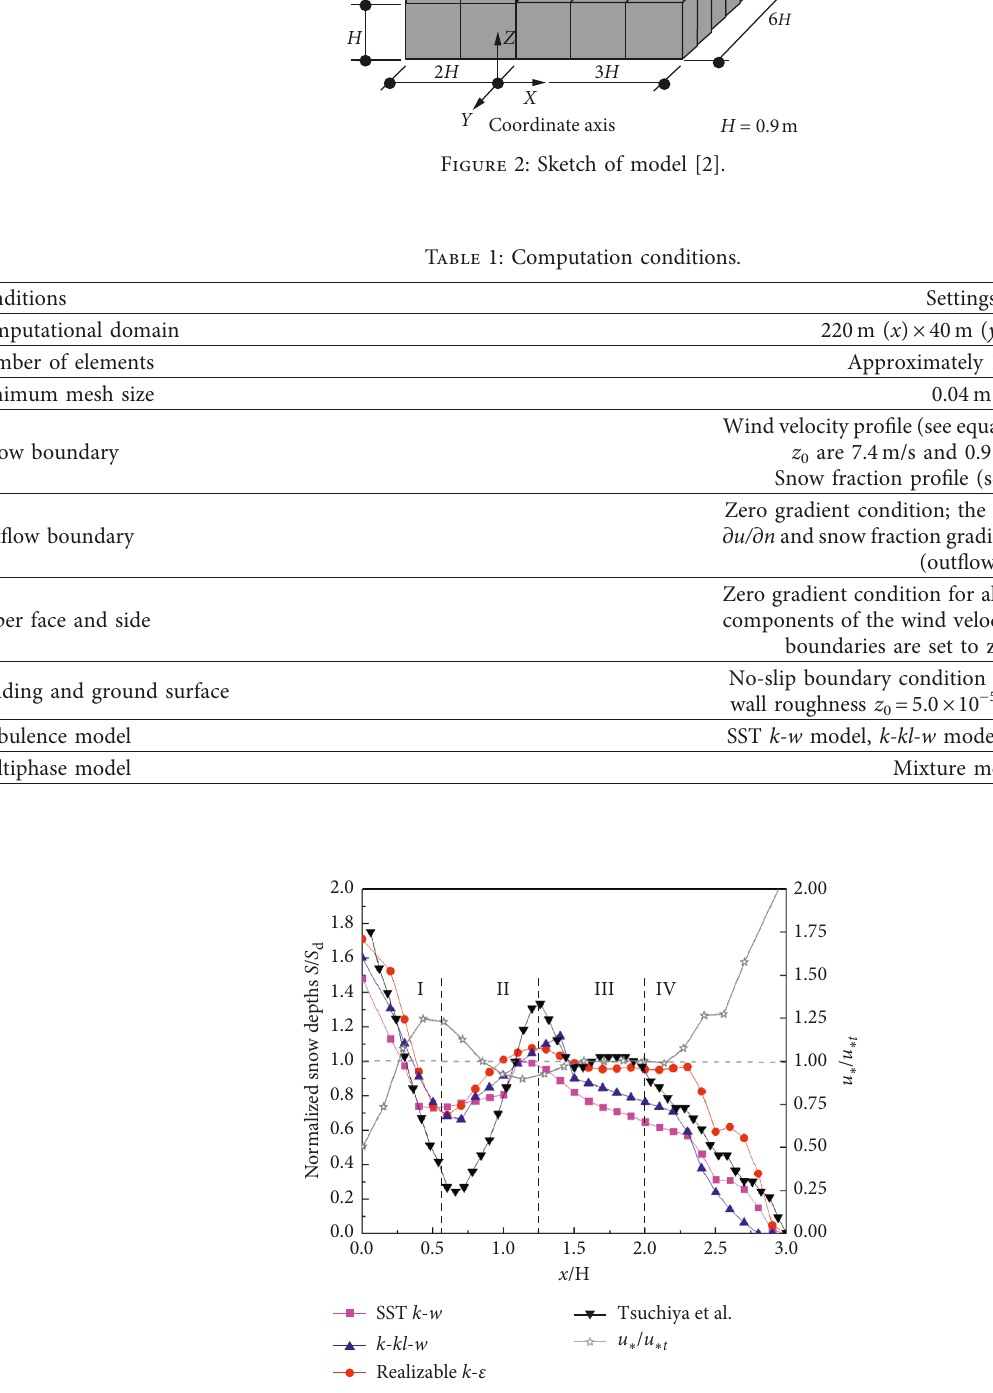
Figure 3: Normalized snow depth obtained by different turbulence models along the line of measurement.